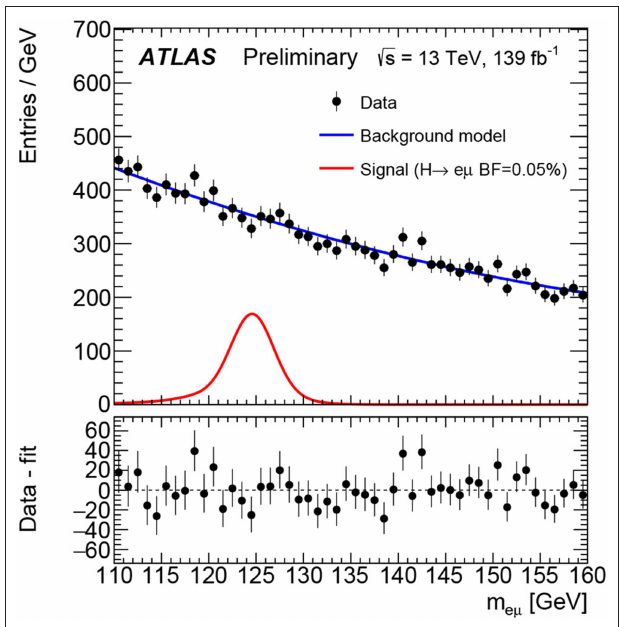
FIGURE 5 | All categories summed together for the e µ channel compared with the background only model. The signal parameterization with branching e µ ) fractions (BF) set to B ( H 0.05 % is also shown (red line). The bottom → = panels show the difference between data and fit. Reproduced from ATLAS